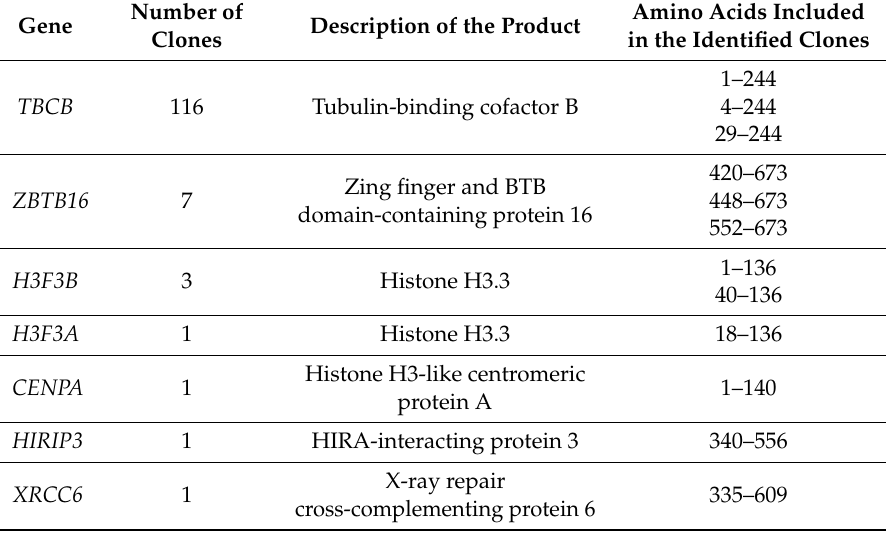
Table 1. Candidate host partners of SseK1 identified in a yeast two-hybrid